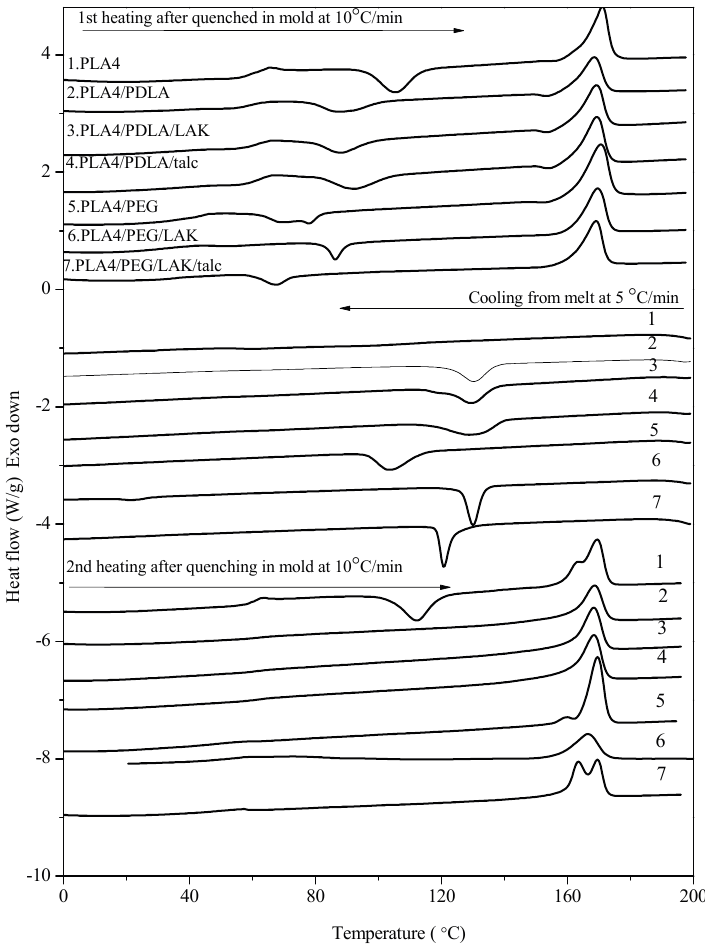
Figure 3. DSC traces (heating-cooling-reheating) of PLA 4032D